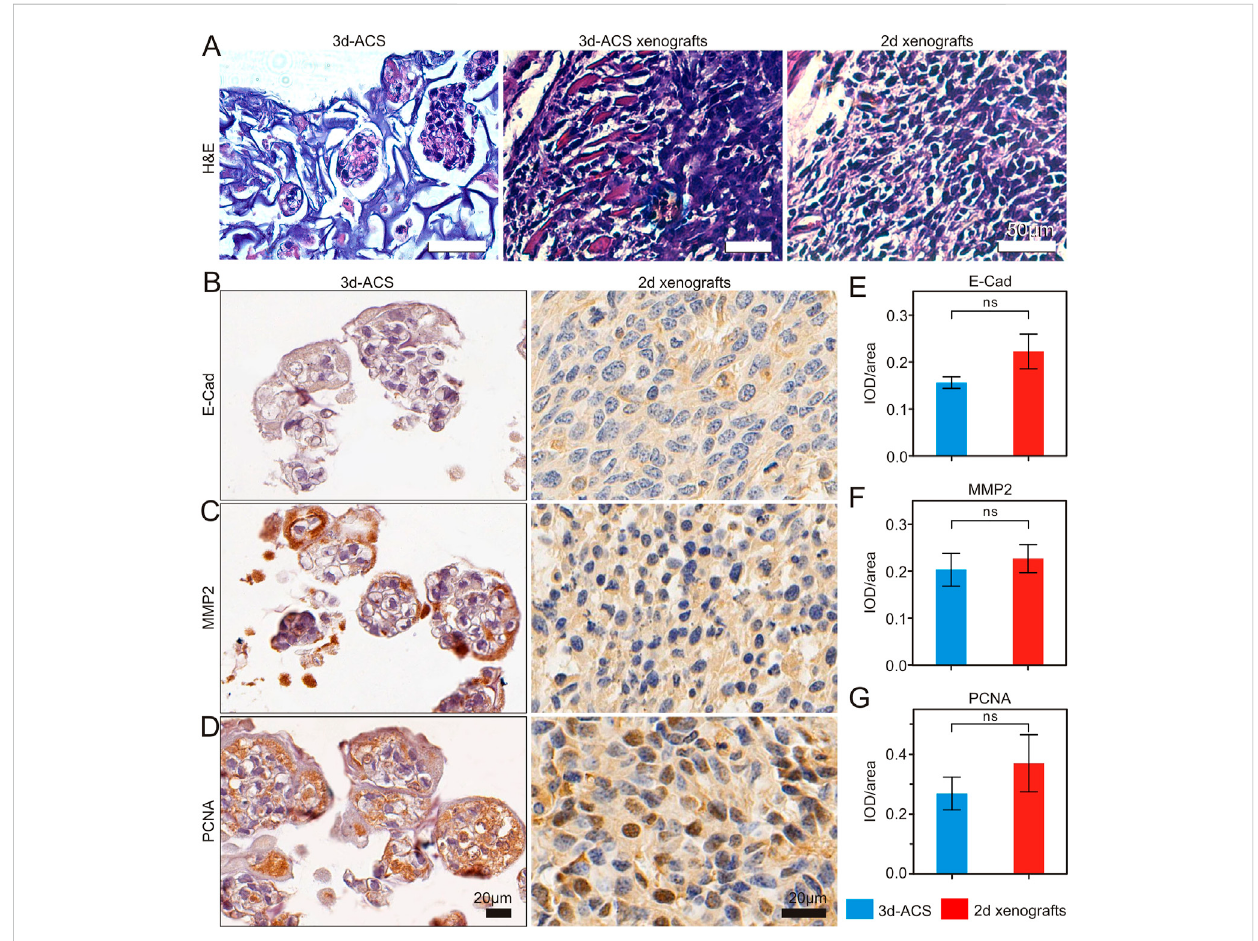
FIGURE 5 The representative H&E and IHC staining of GC cell line (MGC-803) cultured in 3d-ACS and xenograft tumor tissue. (A) Morphology comparison of MGC-803 cells culture 3d-ACS and 3d-ACS or 2d xenograft tumor model. (B – D) E-Cad, MMP2, and PCNA IHC staining of 3d-ACS and 2d xenografts tumor tissues. (E – G) The expression scores in E-Cad, MMP2, and PCNA ( n = 3 per